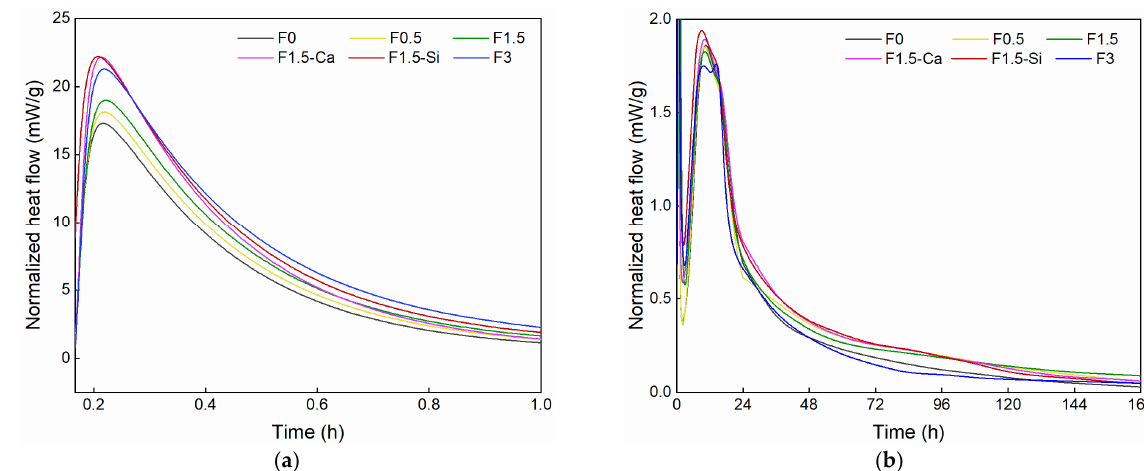
Figure 5. Normalized heat flow of cement paste with coir fibers of various contents and different treatments as a function of time, measured by isothermal calorimetry ( a ) within 1 h and ( b ) within 7 days.